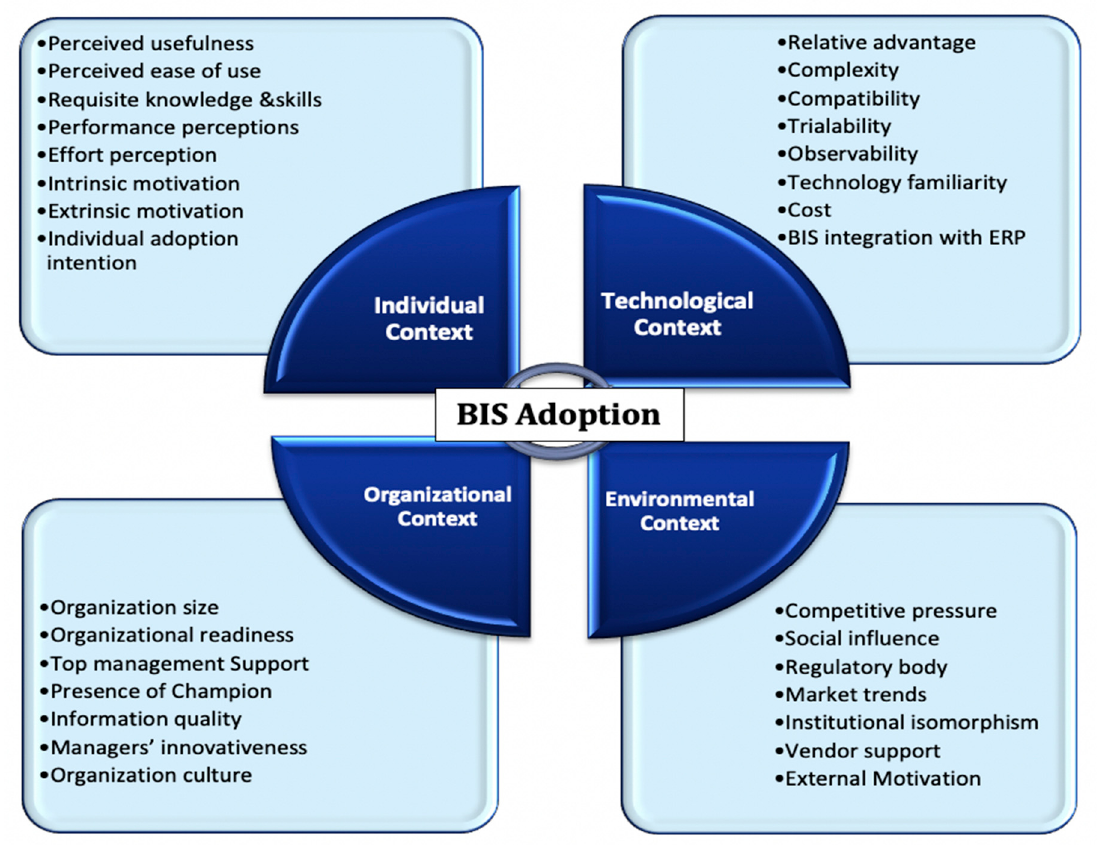
Figure 8. A conceptual model and theoretical framework for BIS adoption.